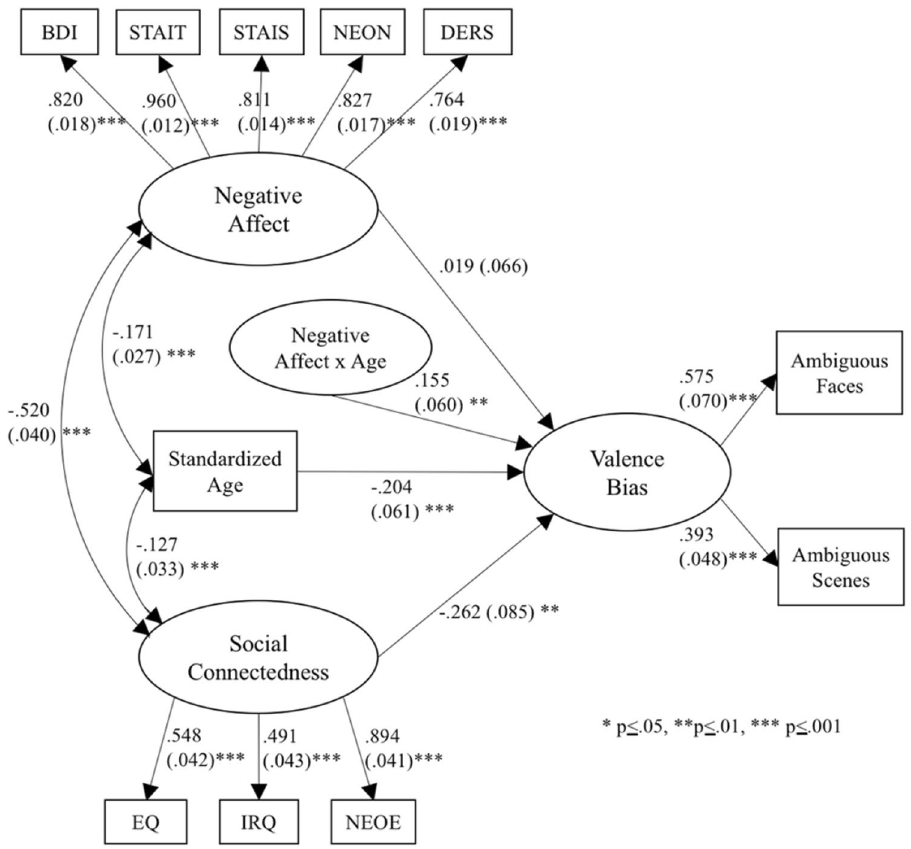
Figure 2. Results of the final model. Social connectedness was inversely associated with a more negative valence bias when controlling for negative affect and age. There was also evidence for a significant interaction between negative affect and age predicting valence bias, such that there was a stronger positive association between negative affect and a more negative bias for older individuals. Values along each arrow are standardized estimates, with associated standard error in parentheses, and significance level represented by asterisks. This model explained 12.9% of the variance in Valence Bias. BDI Beck Depression Inventory, DERS Difficulties